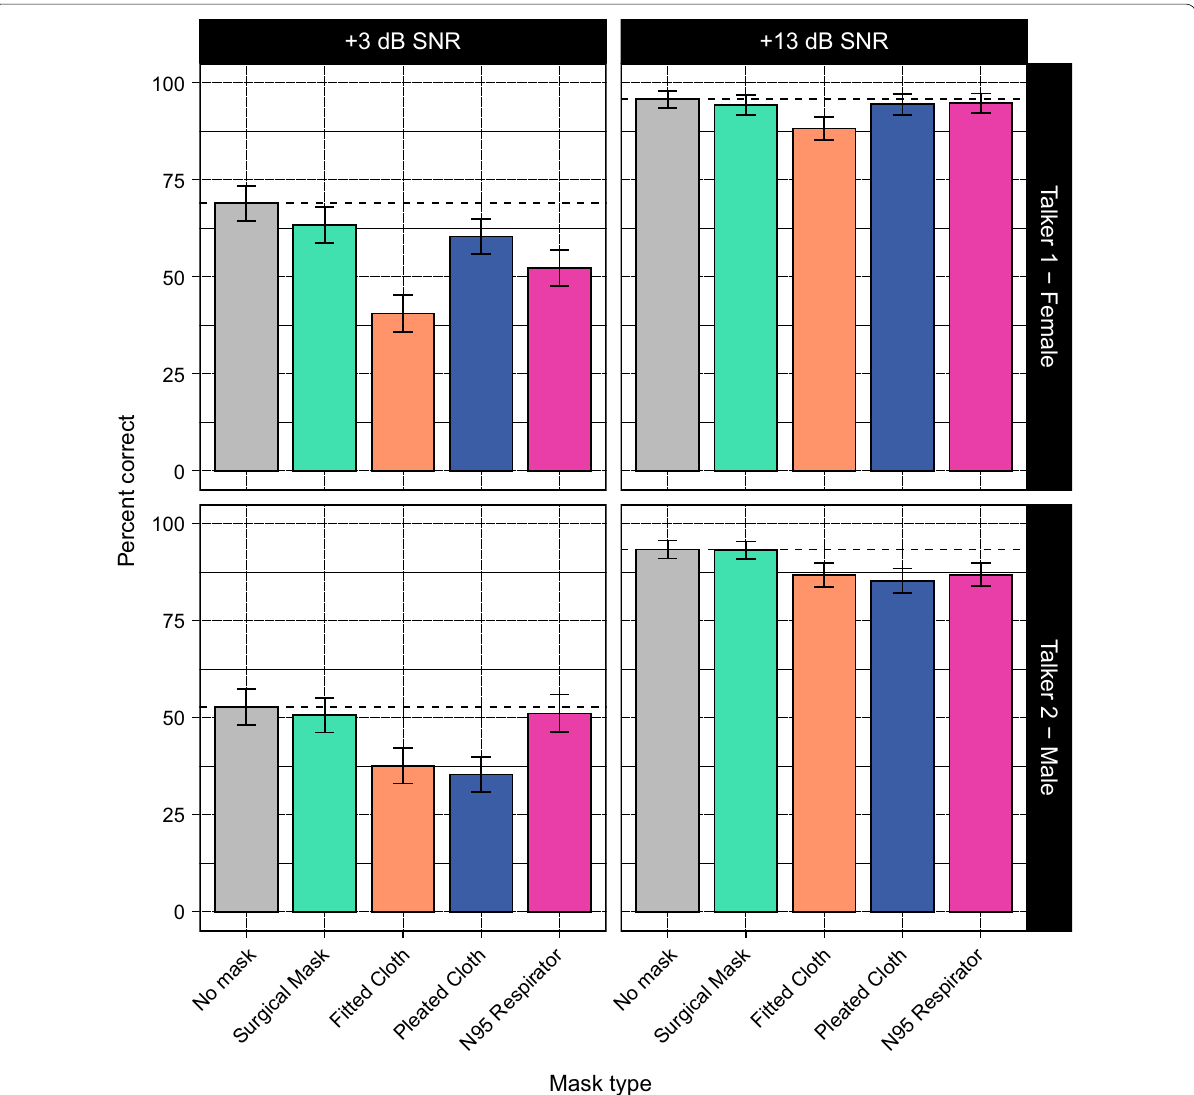
Fig. 1 Average performance by talker, mask, and SNR from the current dataset (collected in 2021). Similar to Toscano and Toscano (2021), listeners were more accurate in the high SNR condition, and more accurate for Talker 1. Compared to the no-mask condition, the surgical mask yielded the best performance, followed by the N95 respirator, and the two cloth masks. Dashed lines indicate the average performance for the no-mask condition in each panel. Error bars indicate 95% confidence